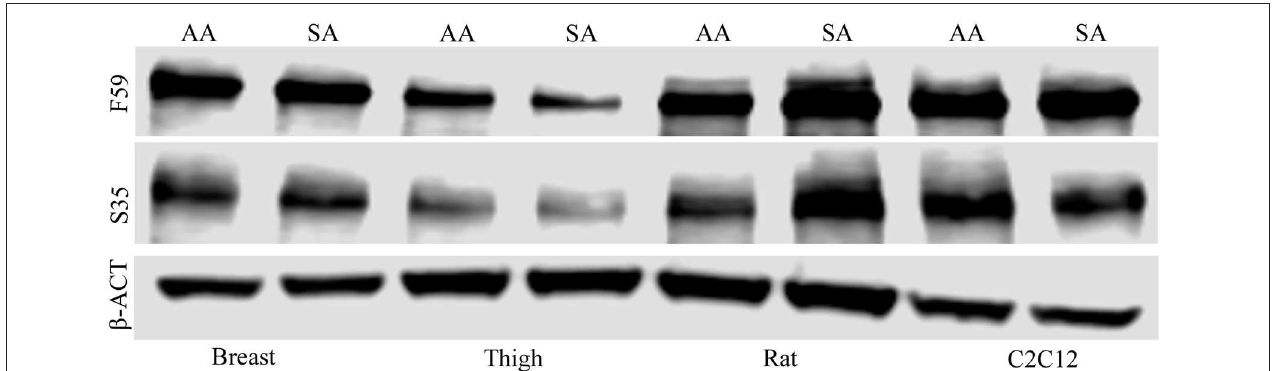
FIGURE 8 | Myosin heavy chain Western blot images. Western blot images of fast (F59) and slow (S35) myosin heavy chain protein isolated from myotubes from C2C12 cells, primary breast, primary thigh, or primary rat cultures after treatment with ammonium acetate (10mM) or sodium acetate (10mM) for 24h. Blots were probed with β -actin to demonstrate equal loading between